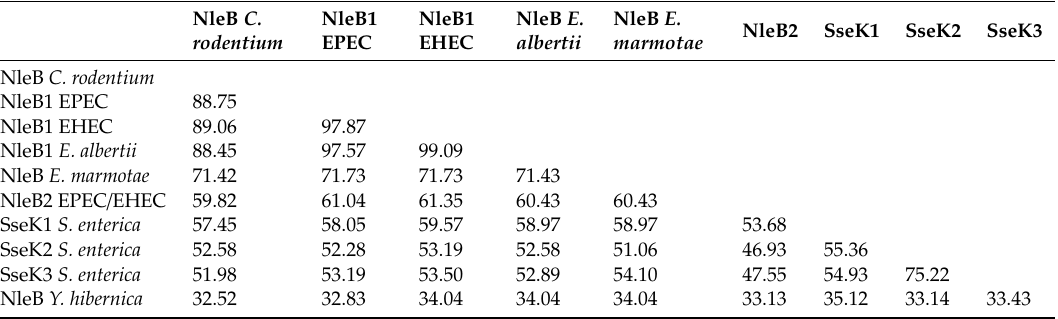
Table 3. Percent identity data for NleB / SseK proteins provided by